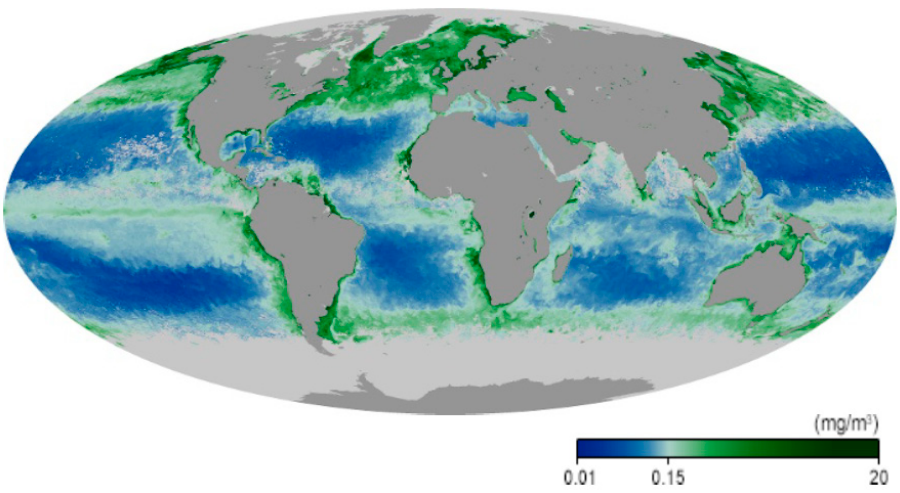
Figure 1. Global chlorophyll a concentration, as seen in a satellite image from May 2022. Courtesy of https://earthobservatory.nasa.gov/global-maps/MY1DMM_CHLORA/MYD28M (accessed on 1 February 2023).